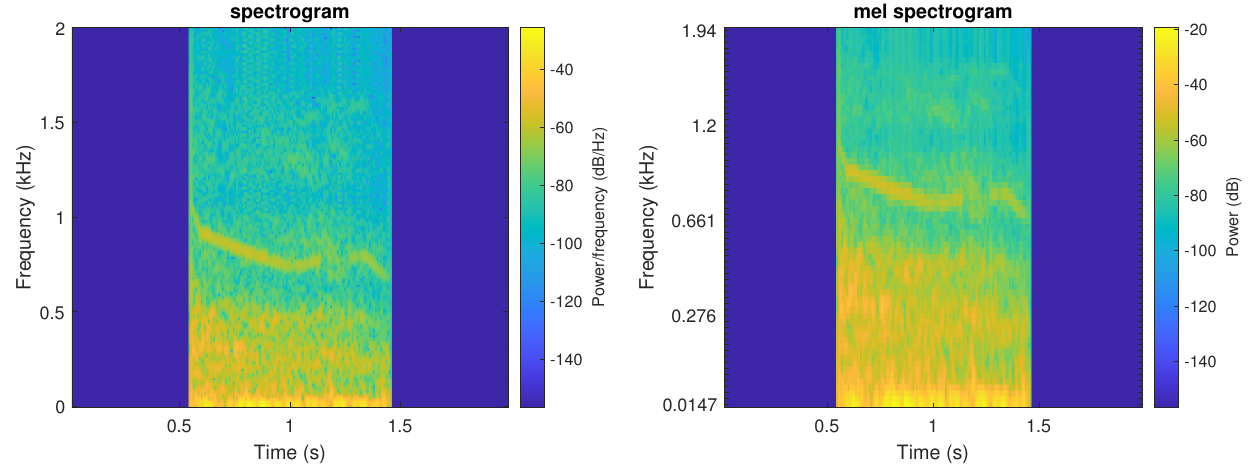
Figure 2. Example of both TF representations of a wheeze event ( left —spectrogram, right —mel